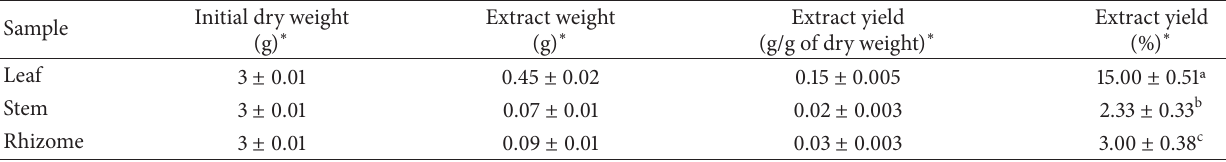
Table 2: Changes in total phenols during storage of extracts from Anemopsis californica . Part of the plant